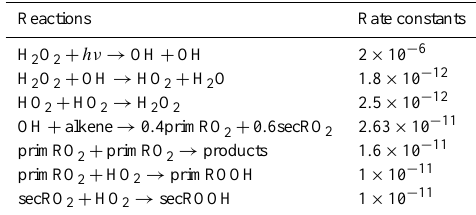
Table C1. Box modeling reactions